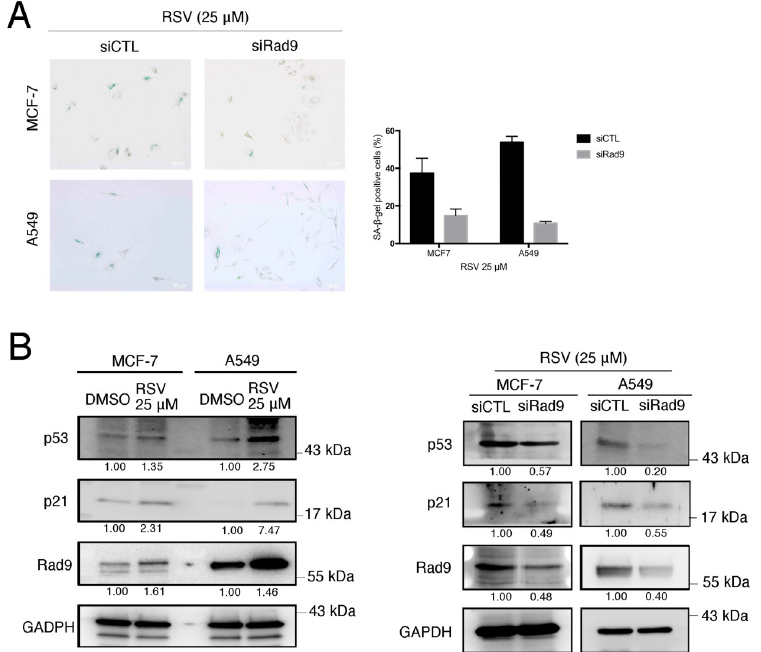
Fig 5. RSV induced premature senescence in a Rad9-dependent manner. (A) SA- β -gal staining was reduced in RSV treated siRad9/MCF-7 and siRad9/A549 cells. Scale bar, 100 μ m, representative of three independent experiments. (B) Western blotting was performed to determine the expression of p53, p21, and Rad9 in RSV or with siRad9 treated in MCF-7 and A549 cells. GAPDH were used as loading controls. Signals on the immunoblots were analyzed by ImageJ, normalized with that of GAPDH.